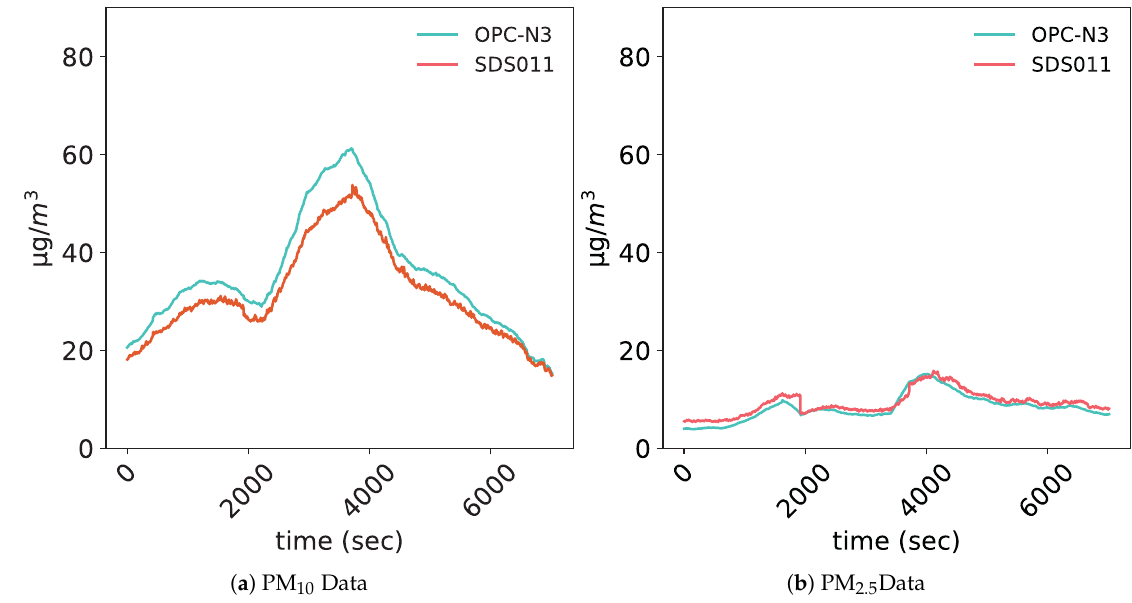
Figure 4. Particulate matter data collection